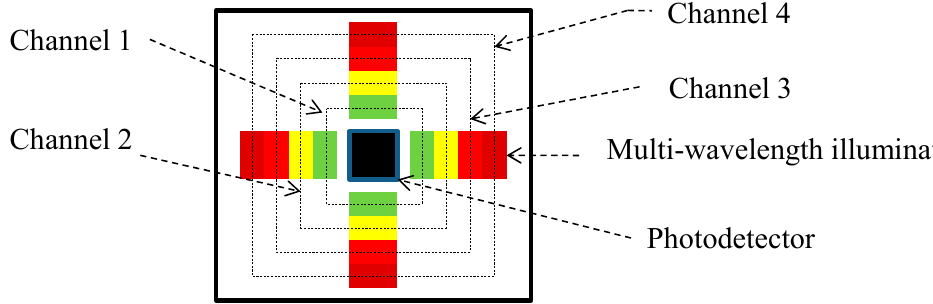
Figure 2. Schematic diagram of opto-electronic patch sensor (OEPS). The multi-wavelength illumination sources of OEPS comprises (1) channel 1 with four green light-emitting diodes (LEDs); (2) channel 2 with four yellow LEDs; (3) channel 3 with four red LEDs and (4) channel 4 with four IR LEDs.